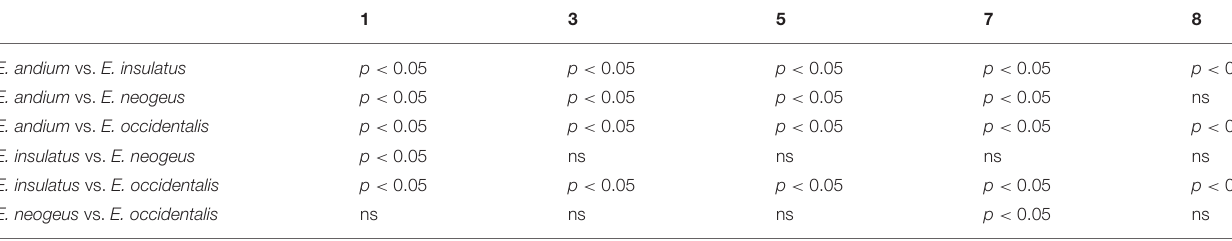
TABLE 3 | Kruskal-Wallis test results for comparative analysis of